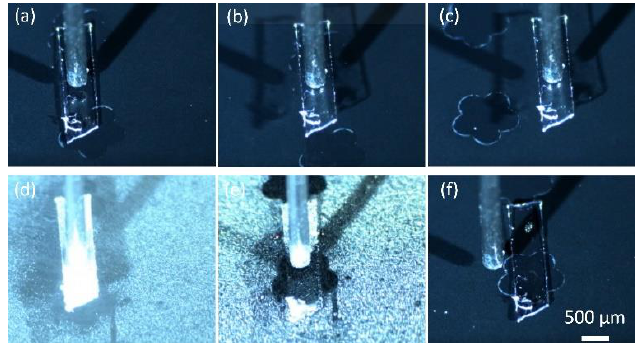
Figure 6. Capillary transport of miniature elastic ribbon. ( a ) a needle is above a ribbon; ( b ) the ribbon